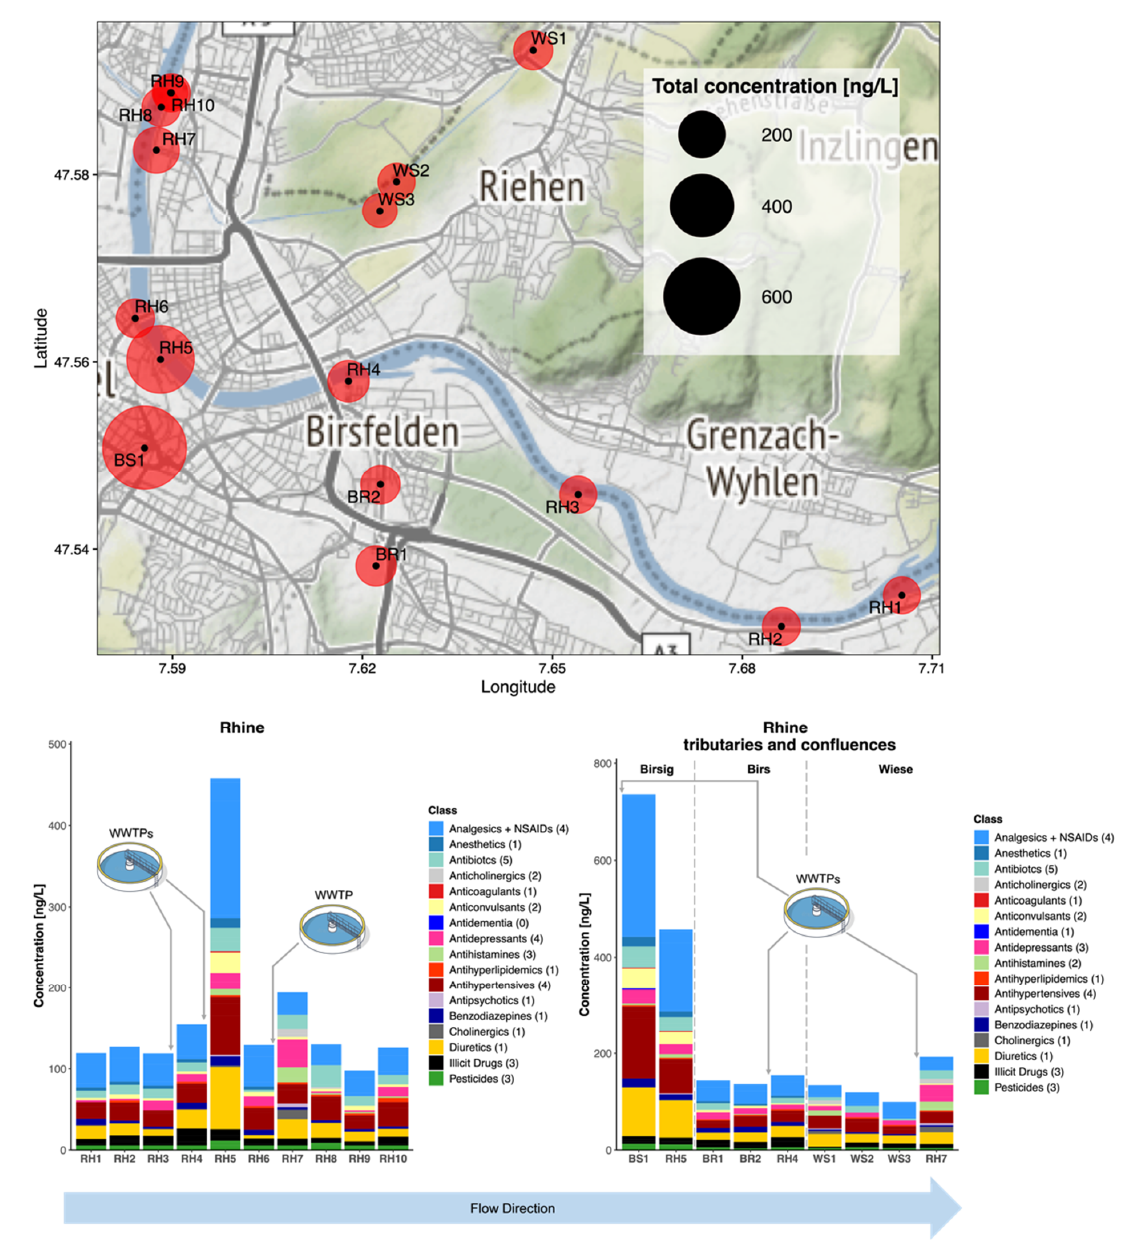
Figure 5. Occurrence of all CECs monitored in the River Rhine in Basel, Switzerland, along with 3 tributaries R. Birs, Birsig, and Wiese in grab samples taken in 2020/2021. Red circles represent sampling points (labelled RH1-10, BS1-2, BR1-2, and WS1-3) and the size of the circle represents the combined total CEC concentration in ng/L. Individual compounds within each class can be found in Table S8.